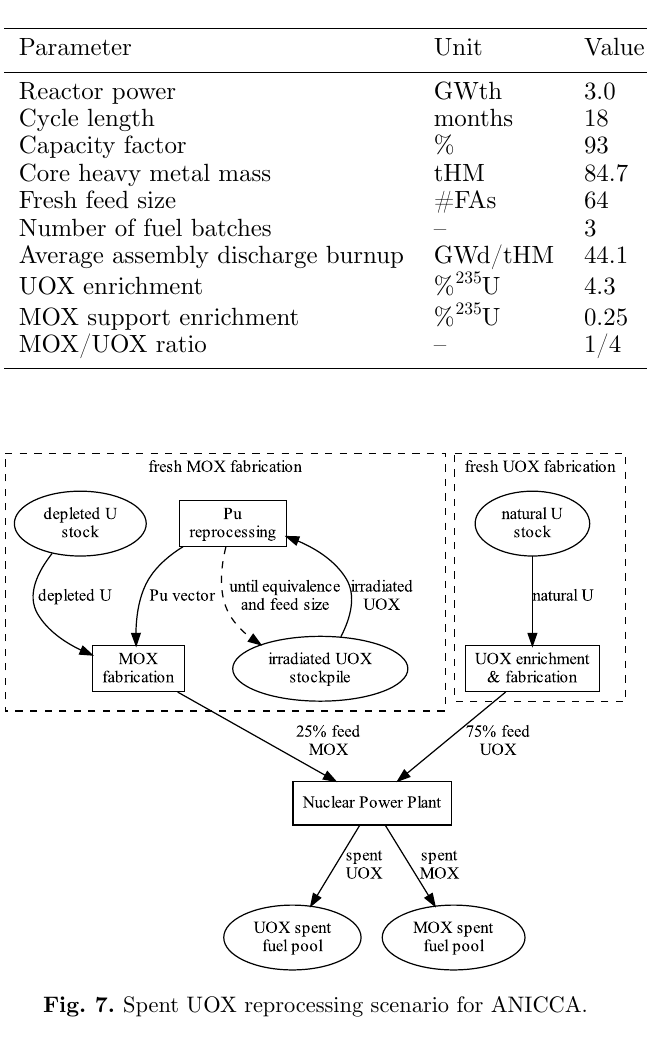
Table 4. In-core fuel management.